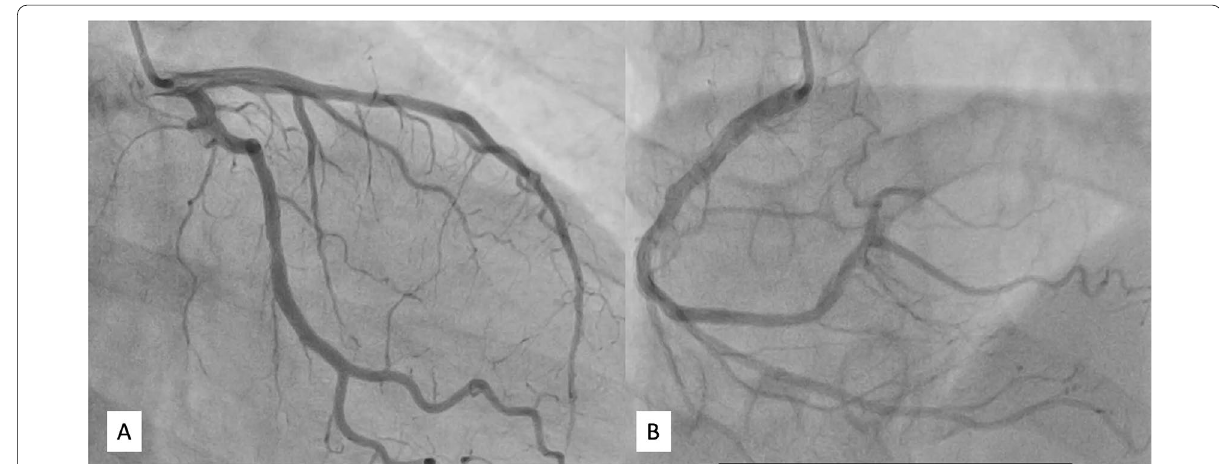
Fig. 3 Still frames of coronary angiogram demonstrating normal coronaries ( A , B